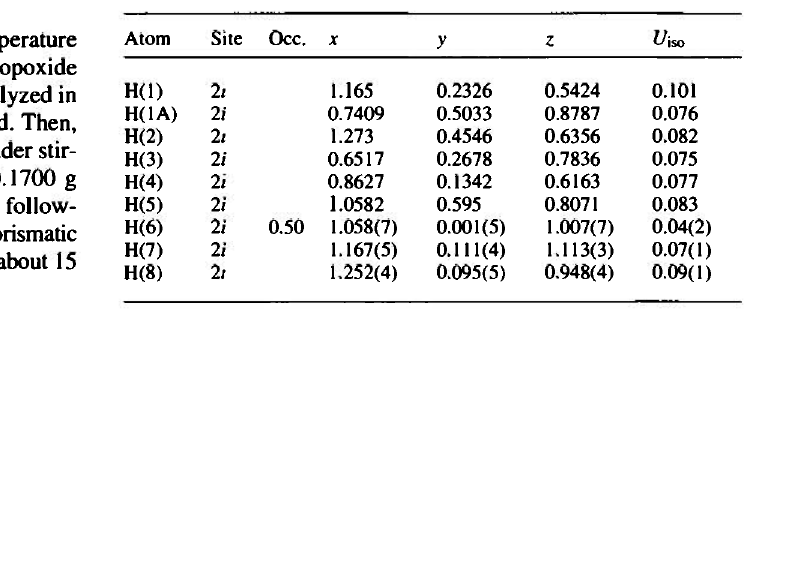
Table 2. Atomic coordinates and displacement parameters (in Ä 2